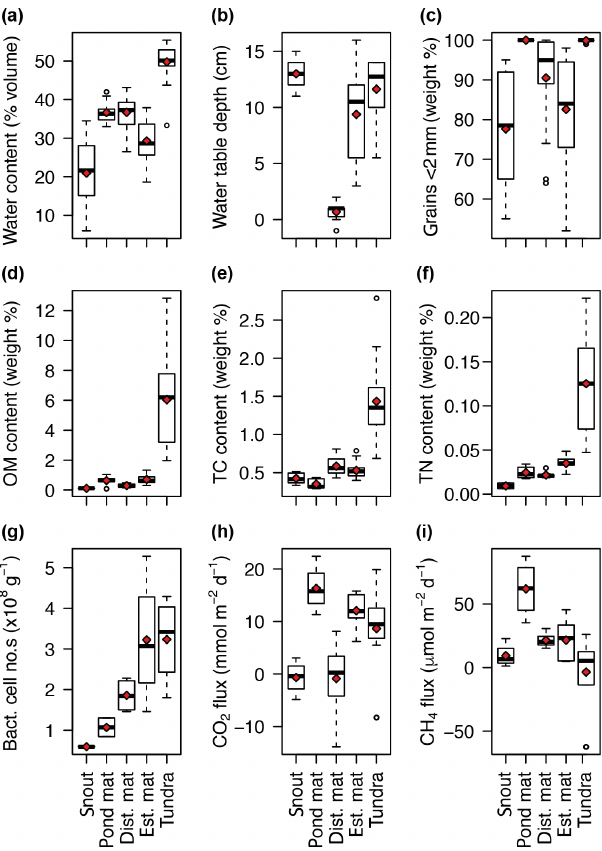
Figure 4. Variation at each site of soil water content (a) , water table depth (b) , weight% of grains < 2mm diameter (c) , organic mat- ter content (d) , total carbon content (e) , total nitrogen content (f) , bacterial cell numbers (g) , CO 2 flux (h) , and CH 4 flux (i) . Hori- zontal black bar represents the median, red diamonds the mean for each site, and open circles the outliers. “dist. mat” is the disturbed mat site; “est. mat” is the established mat site. Water table was not measurable for the pond mat site due to rocky